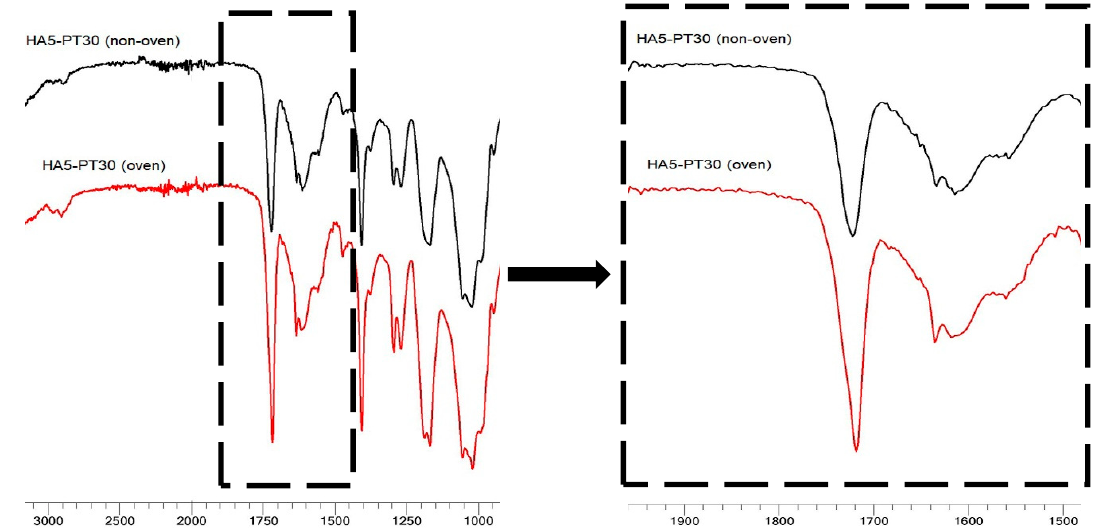
/ cm − 1 ). Cosmetics 2019 , 6 , 59